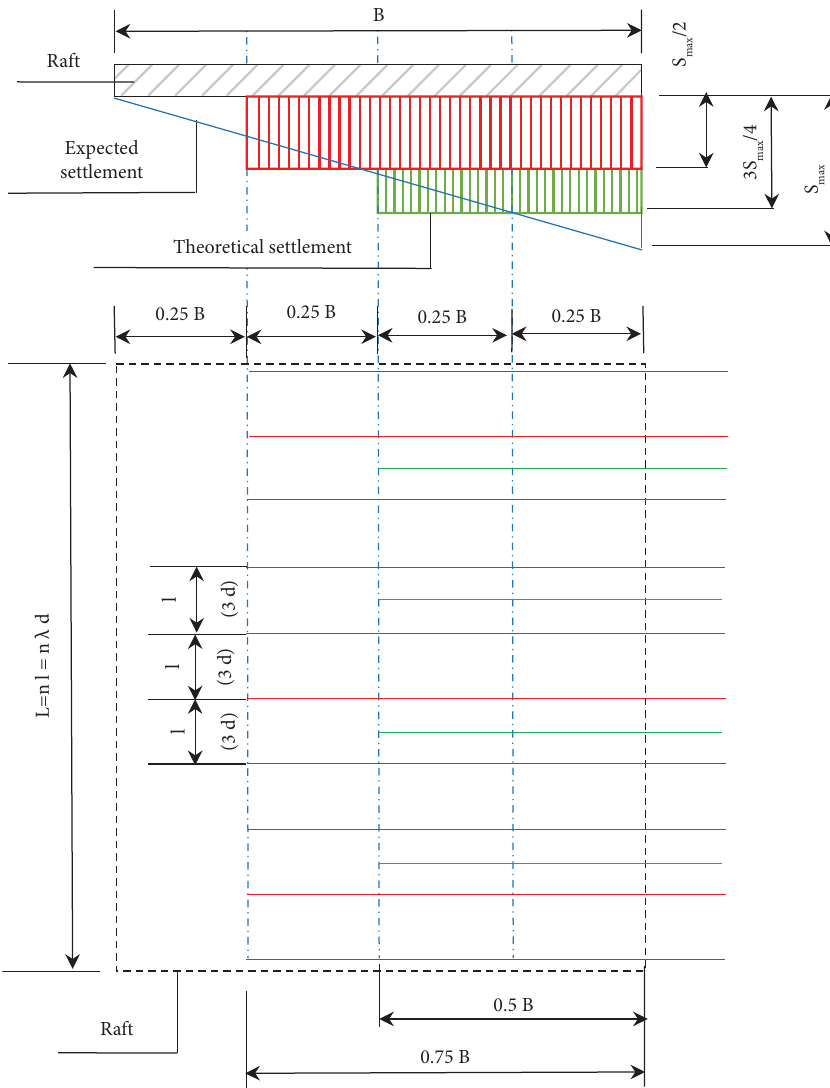
Figure 6: Sketch for rectifcation